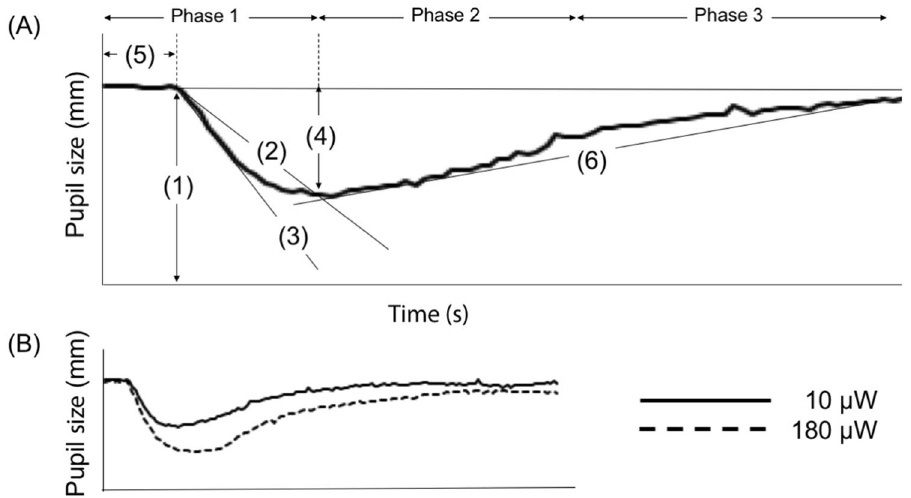
Figure 3. Pupillary light reflex wave. ( A ) (1) initial pupil size (INIT); (2) average constriction velocity (ACV); (3) maximum constriction velocity (MCV); (4) constriction ratio, defined as the difference between the initial and minimum pupil sizes divided by the initial pupil size (DELTA); (5) constriction latency (LAT); and (6) average dilation velocity (ADV). The wave consists of three phases. ( B ) Waves of pupillary light reflex recorded at 10 and 180 μW. Solid line represents a wave recorded at 10 μW, whereas dotted line represents a wave recorded at 180